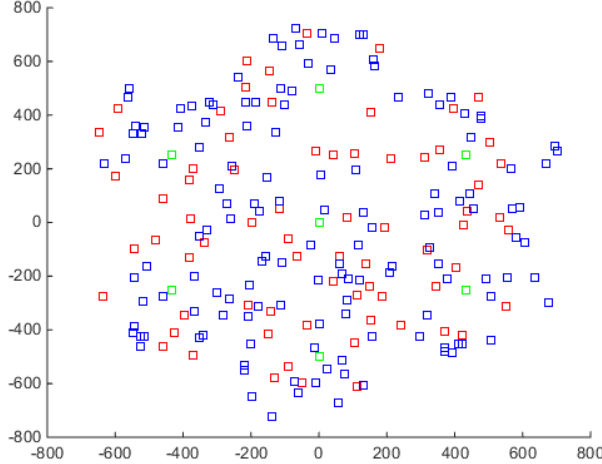
Figure 4. System simulation diagram.